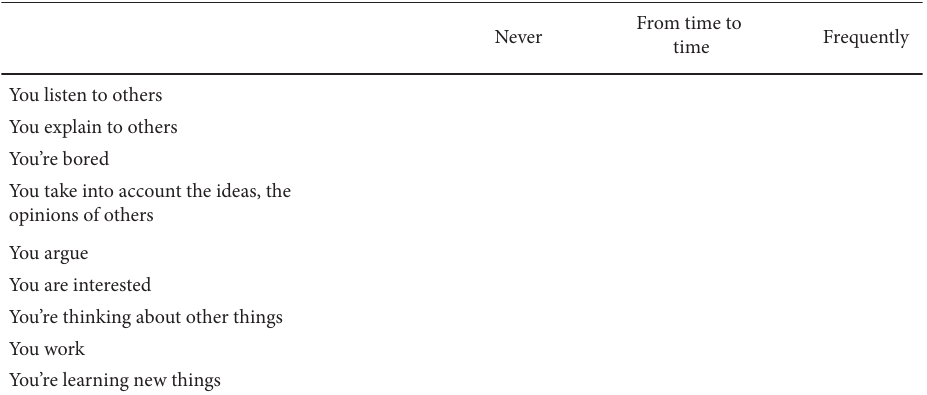
Figure 3: Example of a question whose optional answers are based on an interval scale when examining a pupil’s individual attitude and ability to work in a